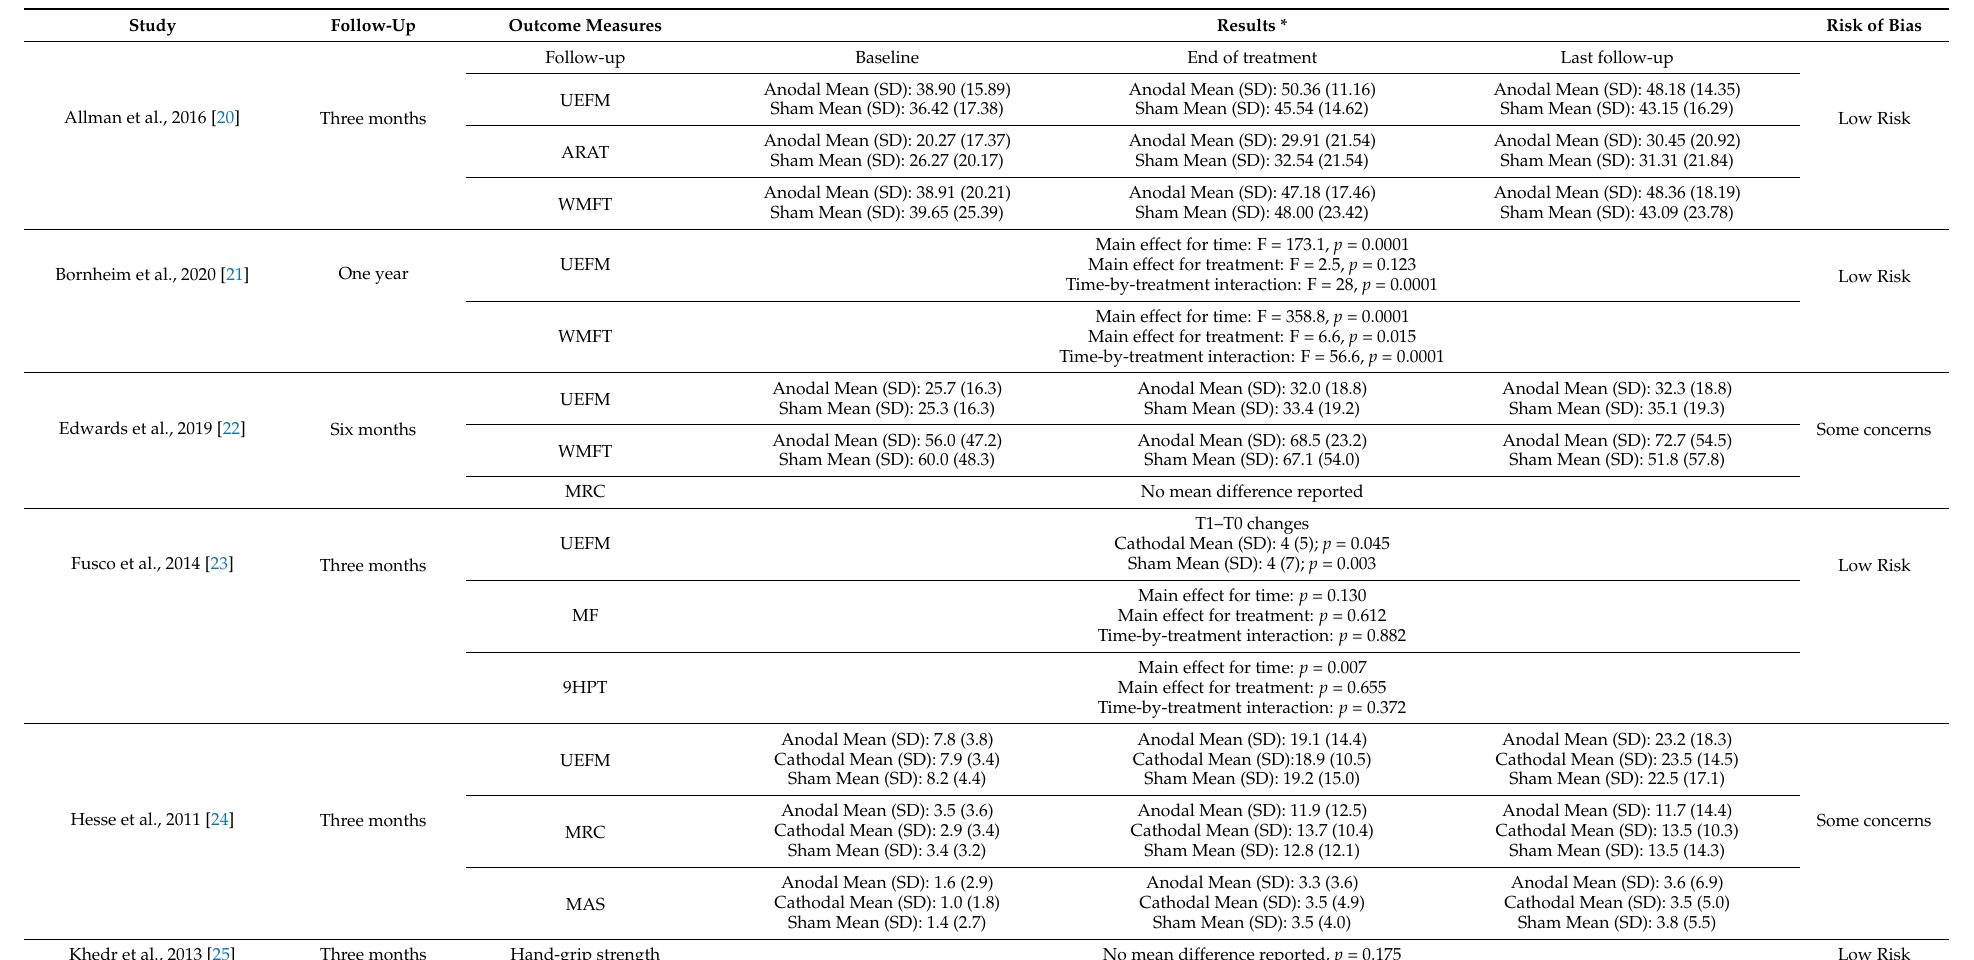
Table 2. Main results of the